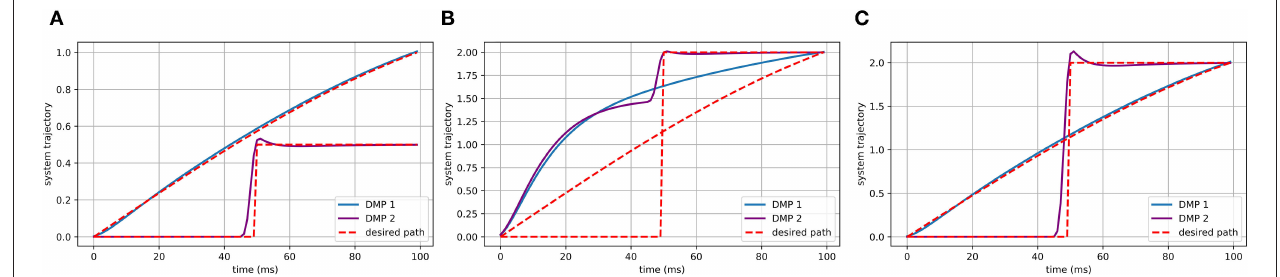
FIGURE 3 | The spatial scaling feature of DMPs. The goals in (A) are 1 and 0.5, which are where the DMPs end up. When we want to get a scaled up version of this trajectory to a goal of 2 by DMPs, if the forcing function, with ( g − y 0 ), then we will end up with this shown in (B) . Once the ( g − y 0 ) term included in the forcing function, however, we get the (C) which is exactly what we want.